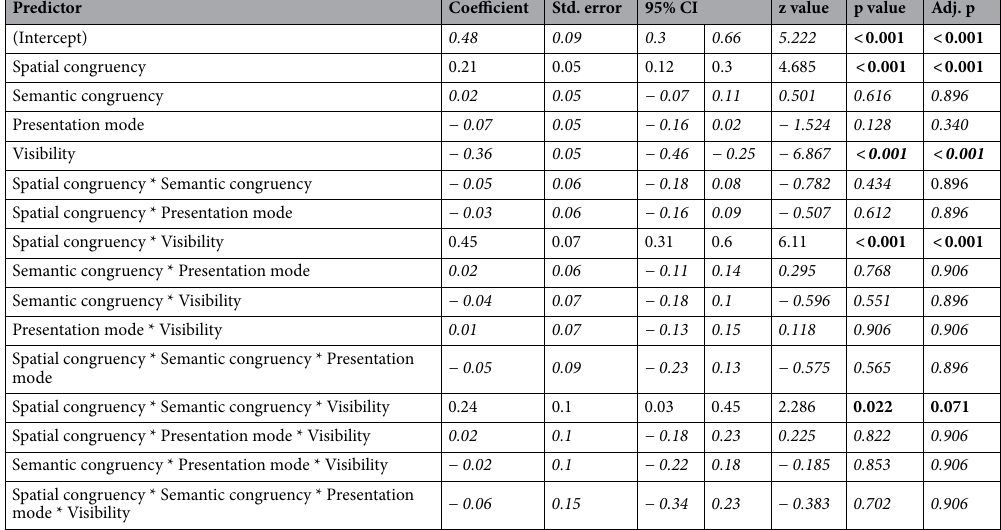
Table 4. Summary of the GLMM fitted for Sound localization accuracy in Experiment 2 (masked pictures). The results pertaining to our hypotheses are shown in roman, the remaining results in italics. Bold indicates significant